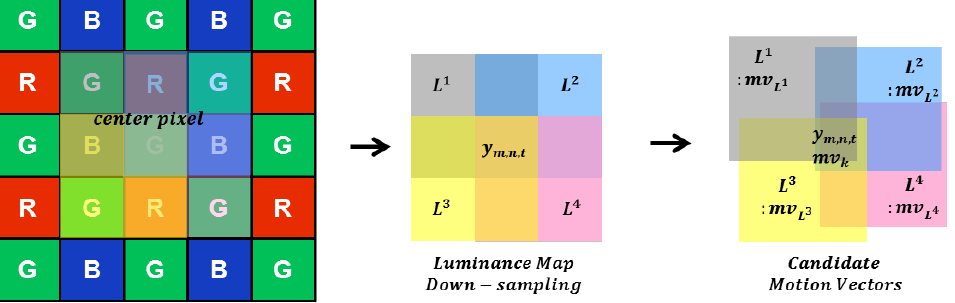
Figure 6. Illustrations of the motion estimation procedure.